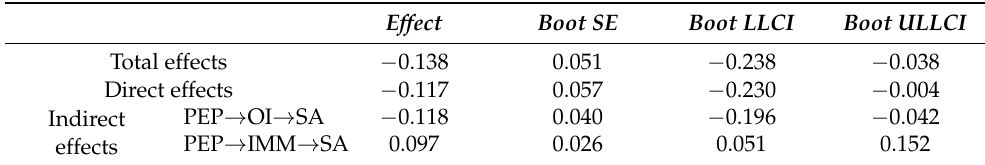
Table 5. Total, direct, and indirect effects of PEP on surface acting.